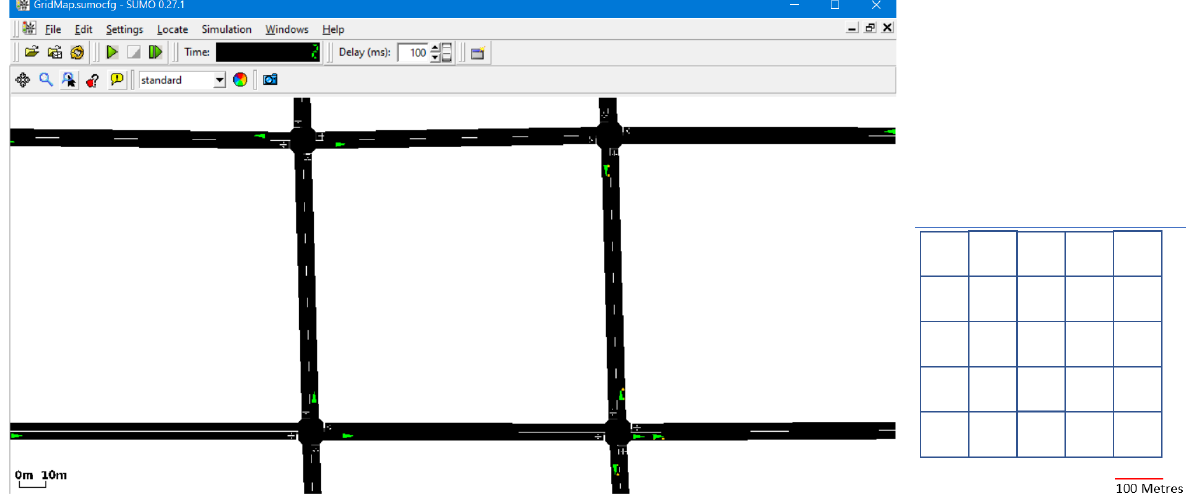
Figure 2. The SUMO traffic simulator using a 5 × 5 lattice map of 100 m to a side. The screenshots show the simulator UI, while the lattice graphic represents the full layout of the map used by the